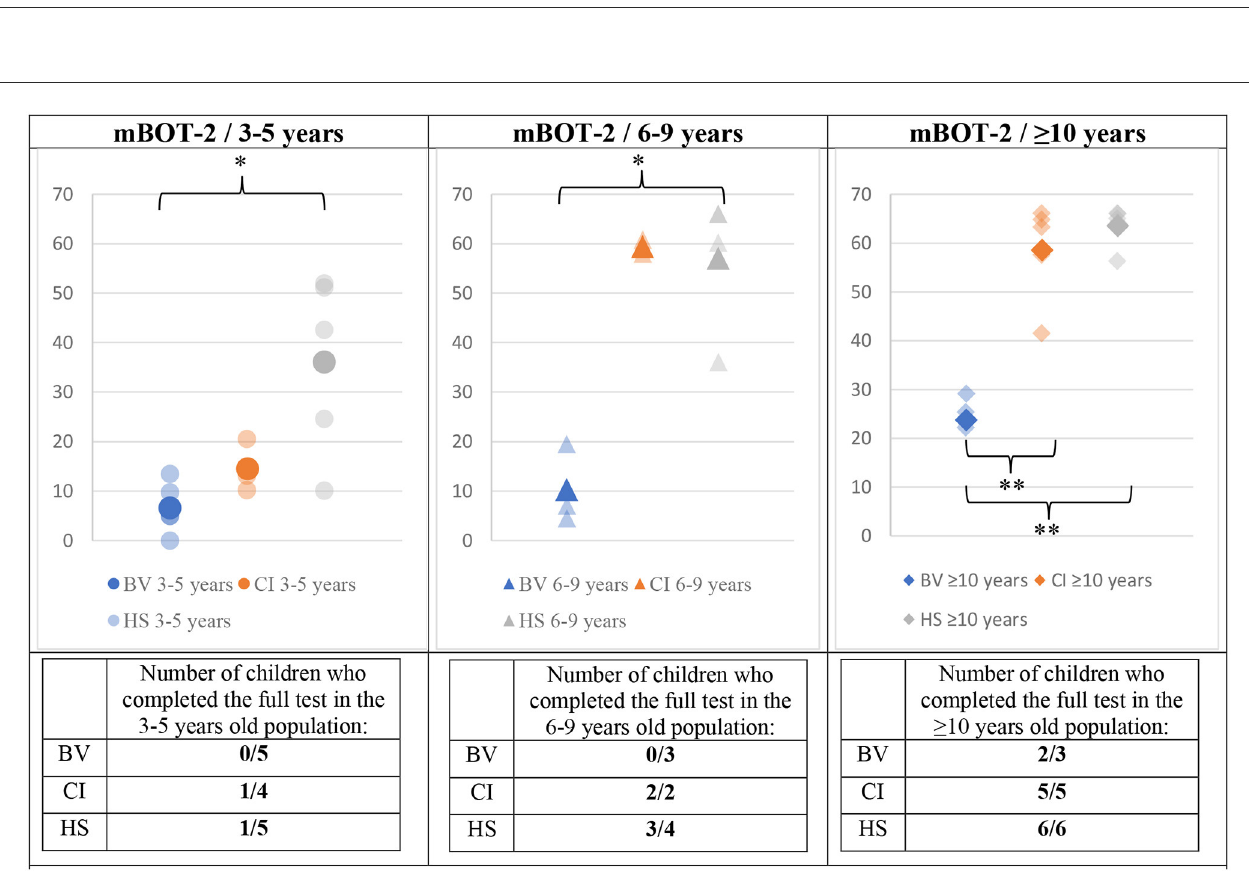
FIGURE5 Means (solid symbols) and individual results (semi-transparent symbols) of the BOT2 for the three age sub-groups, from left to right; 3–5/6–9/ ≥ 10 years old. The number of children who completed the test (if a task of the test is refused by the subject, a score of 0 is given for that task) is presented in a table below each panel. * p < 0.017/** p < 0.004 (with Bonferroni